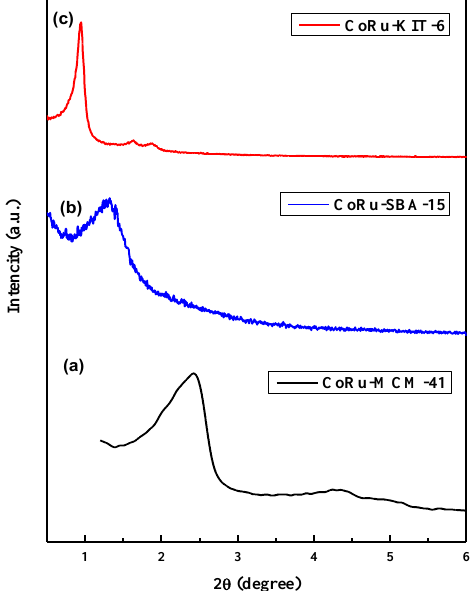
Figure 3. Low angle XRD of three bimetallic mesoporous catalysts: ( a ) CoRu-MCM41; ( b ) CoRu-SBA15; ( c ) CoRu-KIT6.